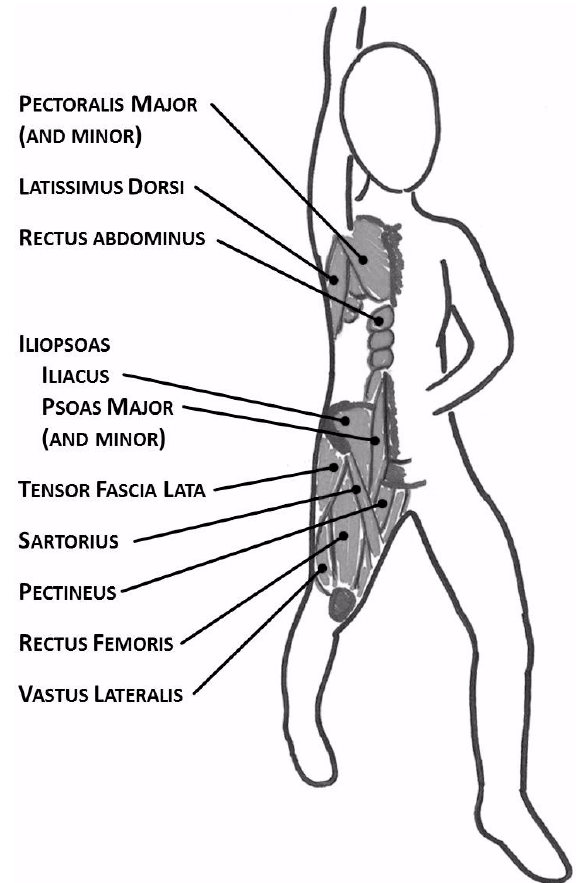
Figure 2. Diagram demonstrating recovery intervention with stretching and concurrent diaphragmatic breathing for experimental 2-compressor teams. The stretch was a shallow lunge with ipsilateral arm raised in the air; the highlighted muscle groups are those targeted by the stretch. Participants were instructed to switch sides approximately every 30